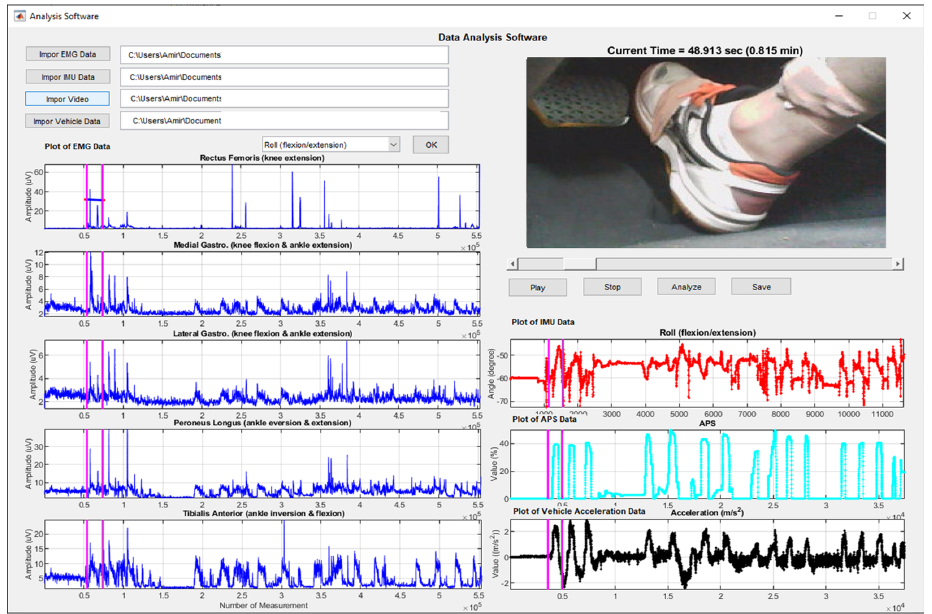
Figure 6. Analysis platform coded in this study (note: vertical pink lines in the left and right plots indicate the range of data selected for analysis.